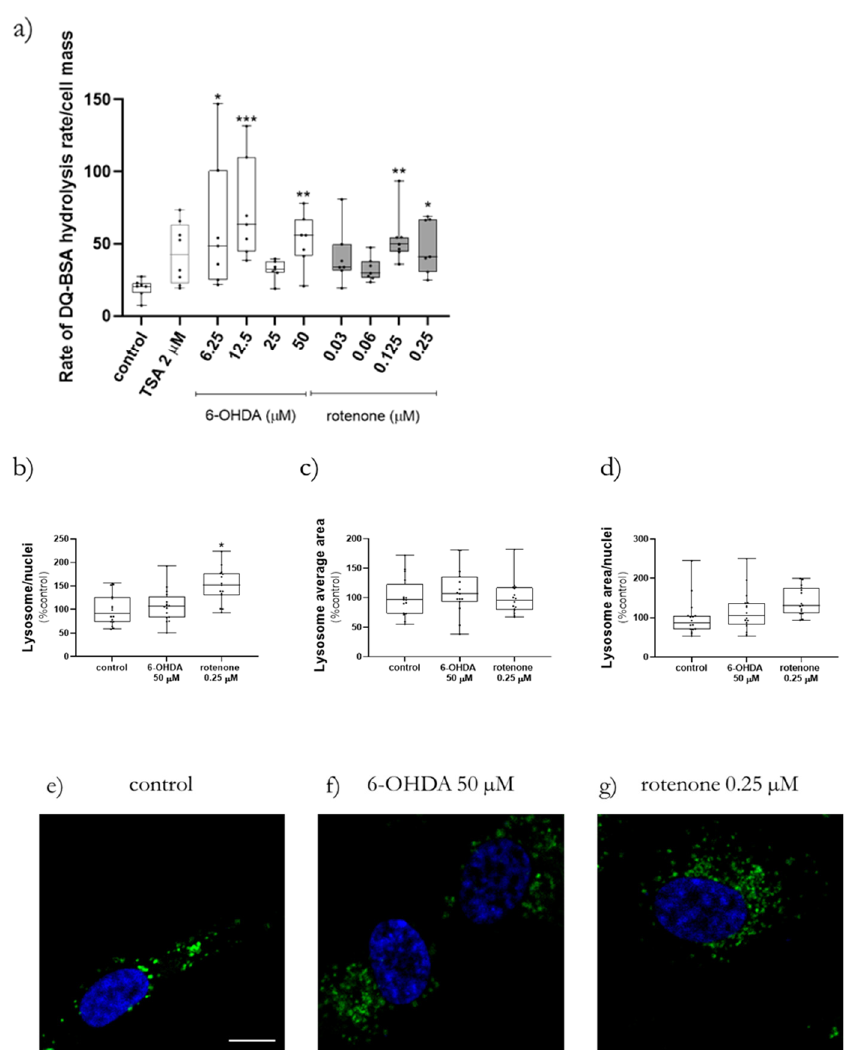
Figure 9. 6-OHDA and rotenone promoted the activation of lysosomal protease activity as well as the increase in the number of lysosomes per cell. The fluorogenic substrate DQ Green BSA was used to assess lysosomal protease activity in cells acutely treated with different concentrations of 6-OHDA and rotenone ( a ). Thrichostatin A (TSA), 2 µM, was used as positive control. Data are represented in boxplots in which each dot represents the average of an independent cell population ( n = 7). Lysosomal parameters lysosome/nuclei ( b ), lysosome average area ( c ) and lysosome area/nuclei ( d ) were also analyzed and are presented in percentage of control. Data are represented in boxplots in which each dot represents the average of an independent cell population ( n = 15–16). Kruskal-Wallis test (One-way ANOVA on ranks) pairwise (control vs. 6-OHDA or control vs. rotenone) was used to assess statistical significance, (*) p < 0.05, (**) p < 0.01, (***) p < 0.001. Representative images were obtained by confocal microscopy (63x objective), scale bar = 10 µm. Nuclei staining is presented in blue and lysotracker green is presented in green ( e – g ). Cells were treated for 24 h with 50 µM 6-OHDA ( f ) or with 0.25 µM rotenone ( g ). Non-treated cells are presented in ( e ).